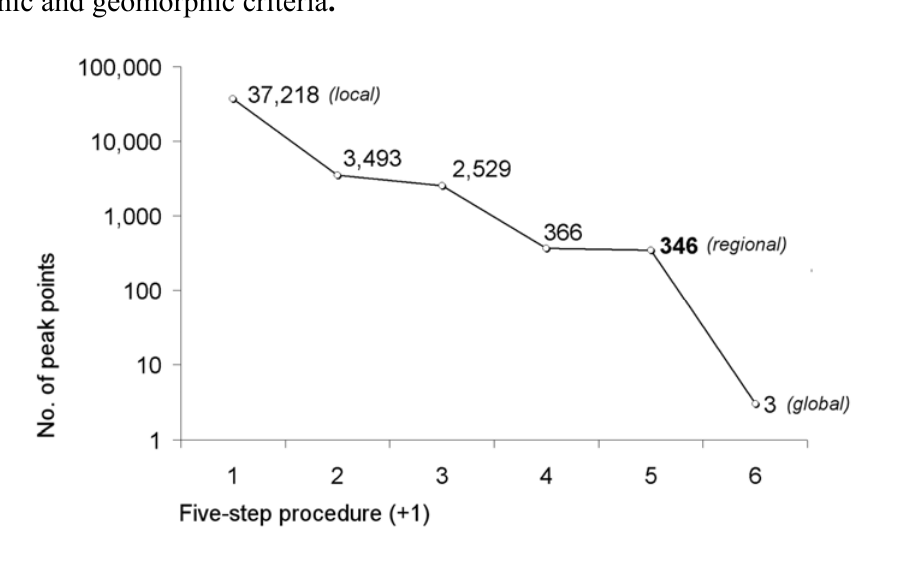
Figure 8. The number of peak points for a case study area: from local (1) to regional peaks (5), and an additional attempt to attain global peaks (6), calculated with reference to the topographic and geomorphic criteria